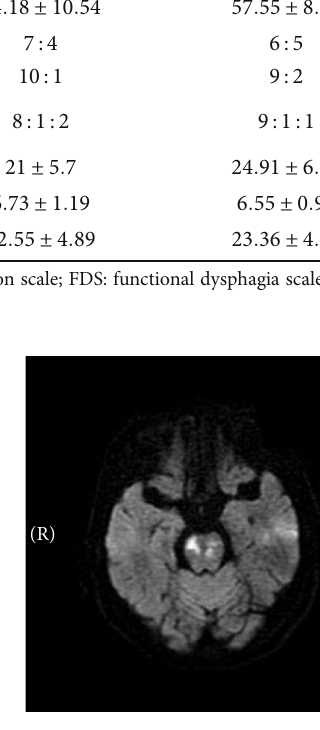
Figure 3: Pontine stroke.